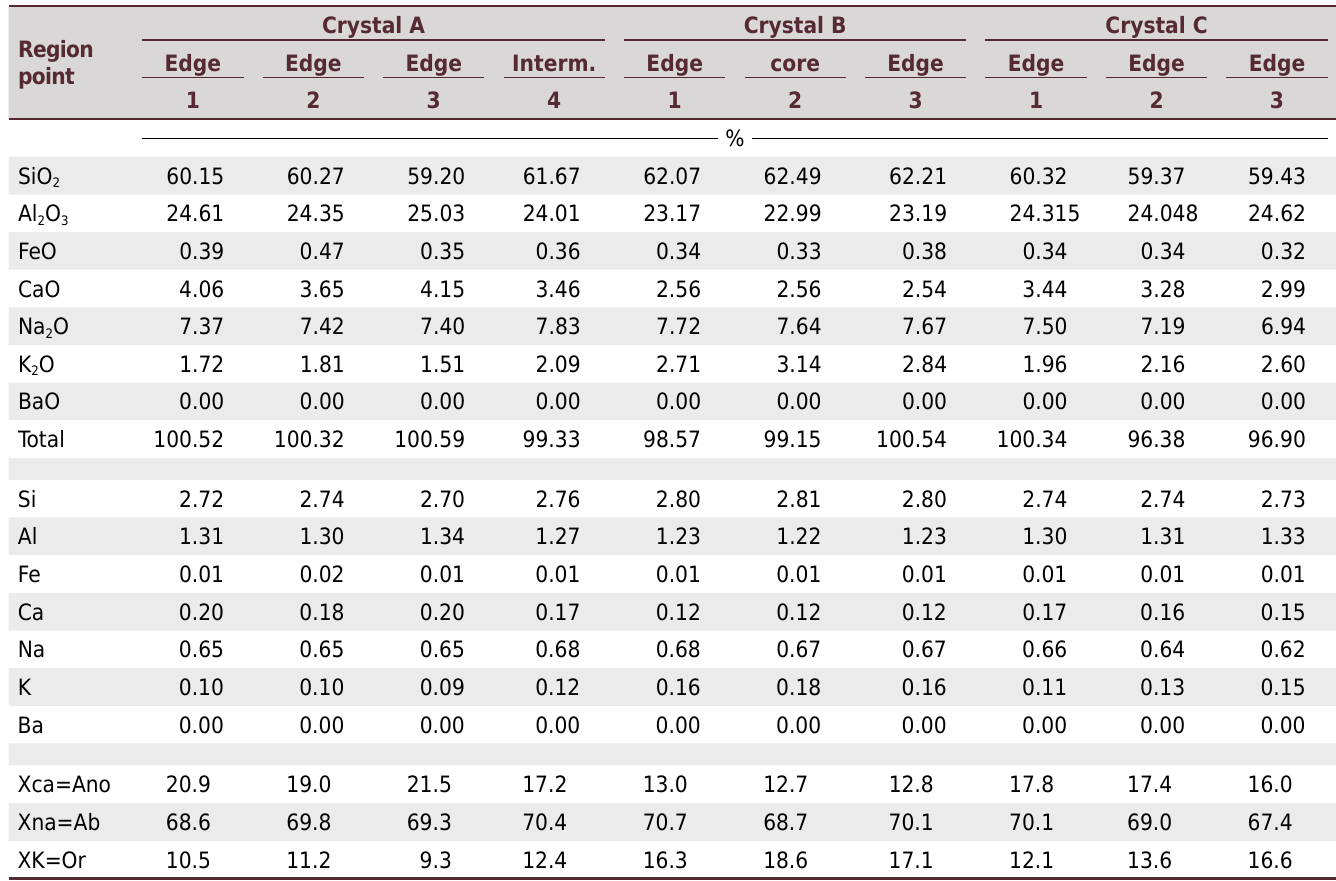
Table 4. Microchemical analyses in feldspars crystals in C2 horizon, P4 Region point